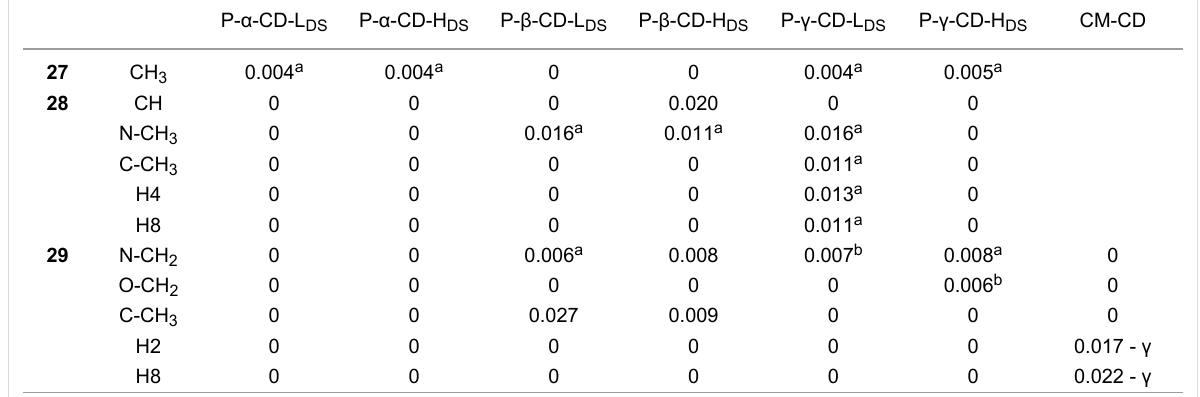
Table 5: Enantiomeric differentiation in ppm in the 1 H NMR spectra (400 MHz) of 27 – 29 (10 mM) with P-CDs and CM-CD [31] in D 2 O. The concentra- tion of the cyclodextrin is 20 mM unless otherwise